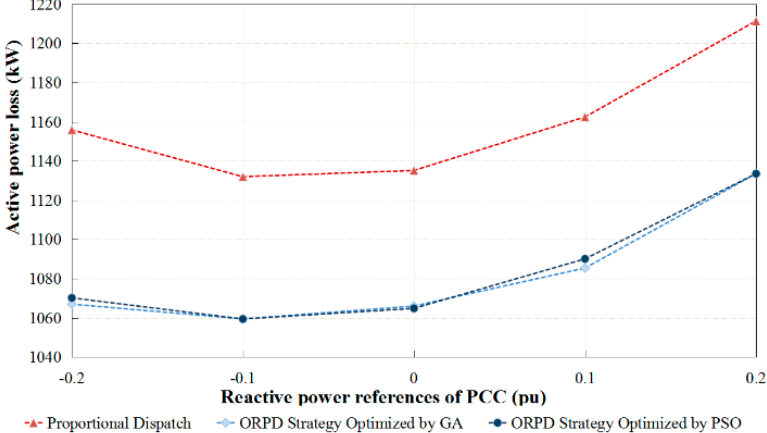
Figure 14. Total loss curves of the optimal reactive power dispatch (ORPD) strategy and proportional dispatch as the reference reactive power changes at the PCC.